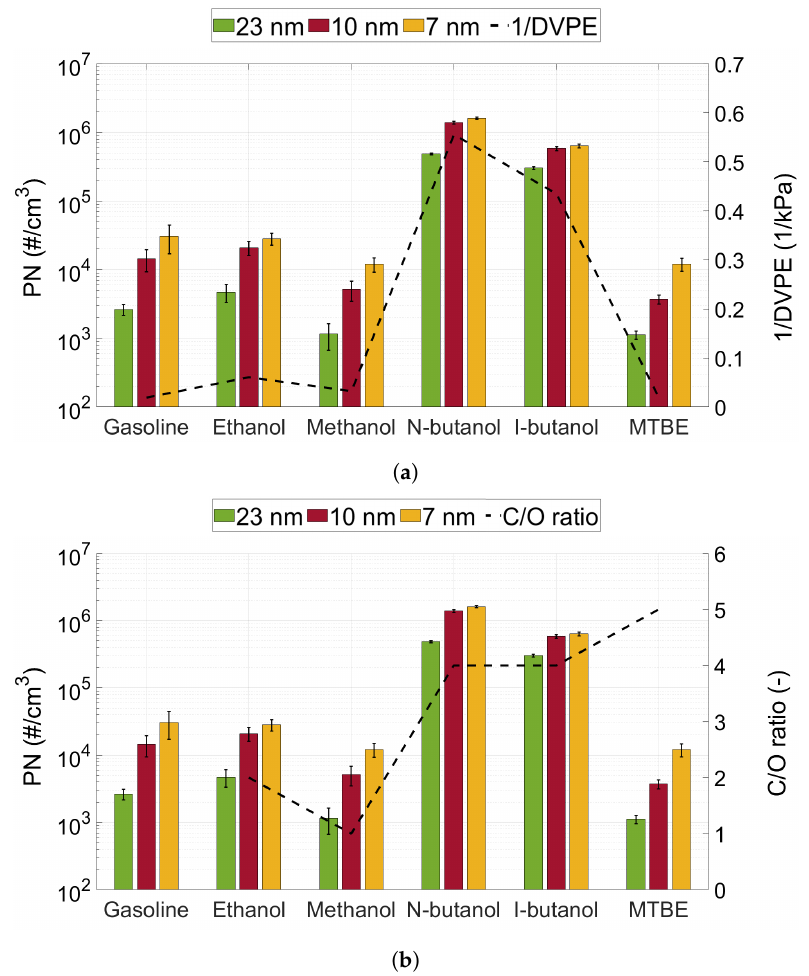
Figure 5. Particle emissions measured using the CPCs (cut-off 23, 10 and 7 nm) compared to the ( a ) DVPE and ( b ) C/O-ratio of the fuels. No value for C/O-ratio is displayed for gasoline as its oxygen content was 0 vol-%. The error bar show the normalised random error ( ± (cid:101)